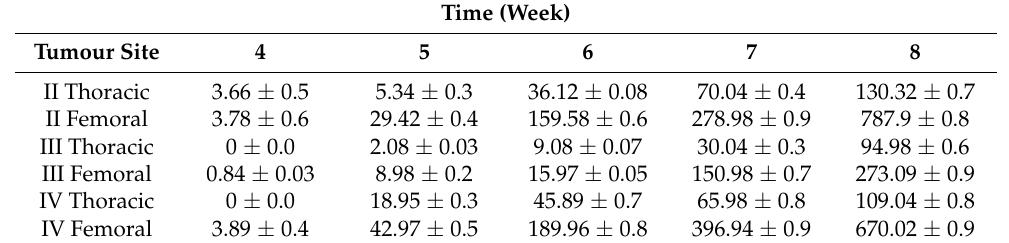
Table 1. Xenograft tumor growth: tumor volume in mm 3 in all groups and 10 mice per group. Four sites were injected in each mouse. Left sites relating to tumors are summarized in Table 1. In groups II, III, and IV, all of the injected tumours grew, which allowed us to assess 120 tumours in total. Data is expressed as mean ± SD.